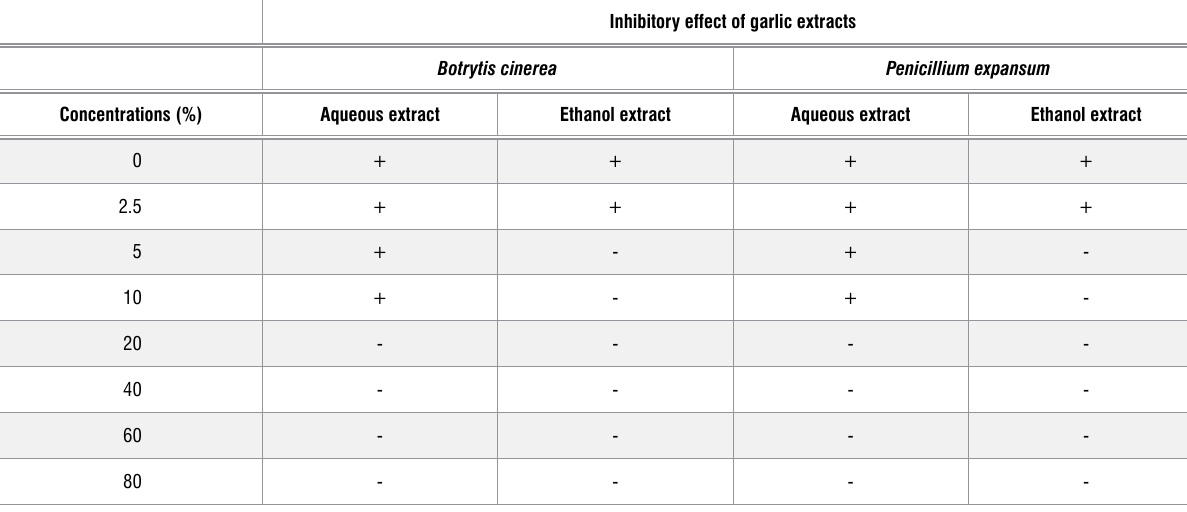
Table 3: Inhibitory effects of aqueous and ethanol diluted garlic extracts against conidial germination of Botrytis cinerea and Penicillium expansum